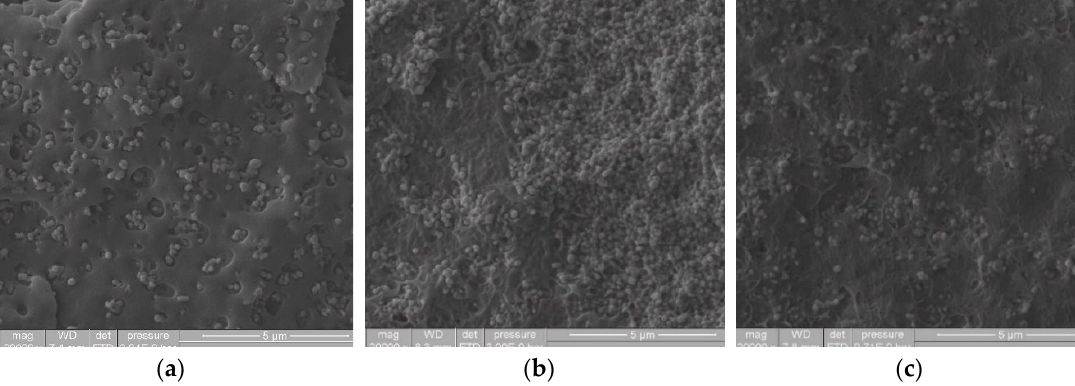
Figure 2. SEM images at 20,000 × of the dispersed pigment in masterbatch compounds fabricated by USME-VF, based on 30 wt% of TiO 2 and PE matrix of different rheology. ( a ) MFI = 2; ( b ) MFI = 20; ( c ) MFI = 50.